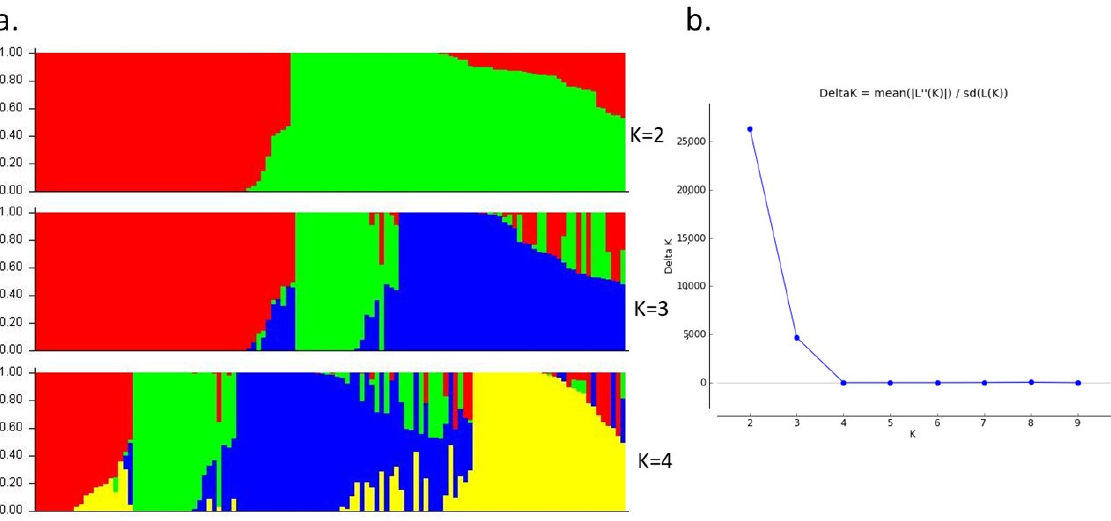
Figure 2. Population structure analysis using membership probability (Q-values) for 120 peanut genotypes. ( a ) Bar plot for different possibility of subpopulation K = 2 to 4 was created with each color representing one cluster. ( b ) Delta K ( Δ K) calculated between K = 2 to K = 9 using information from STRUCTURE analysis indicates that there are two major subpopulations (K = 2).